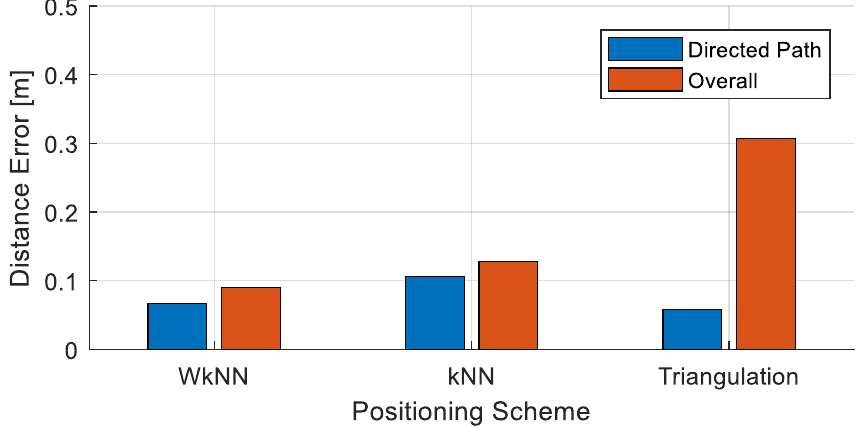
Figure 8. Comparison of positioning errors of each scheme.